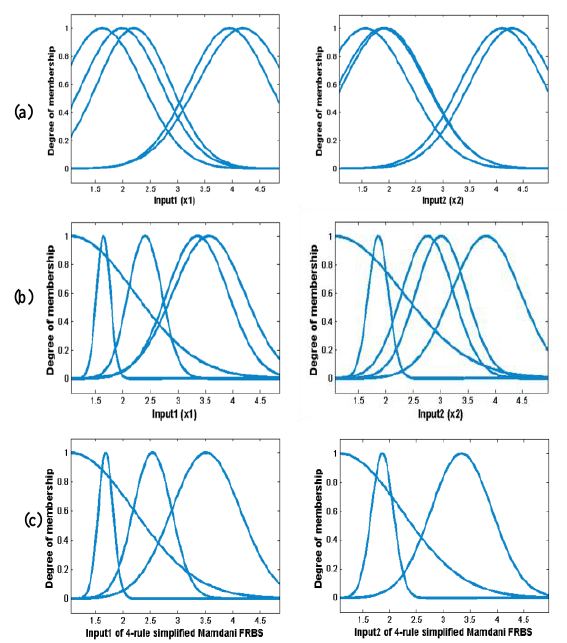
Fig. 8. The membership functions from (a) 1 st stage; (b) 2 nd stage; (c) 3 rd stage.